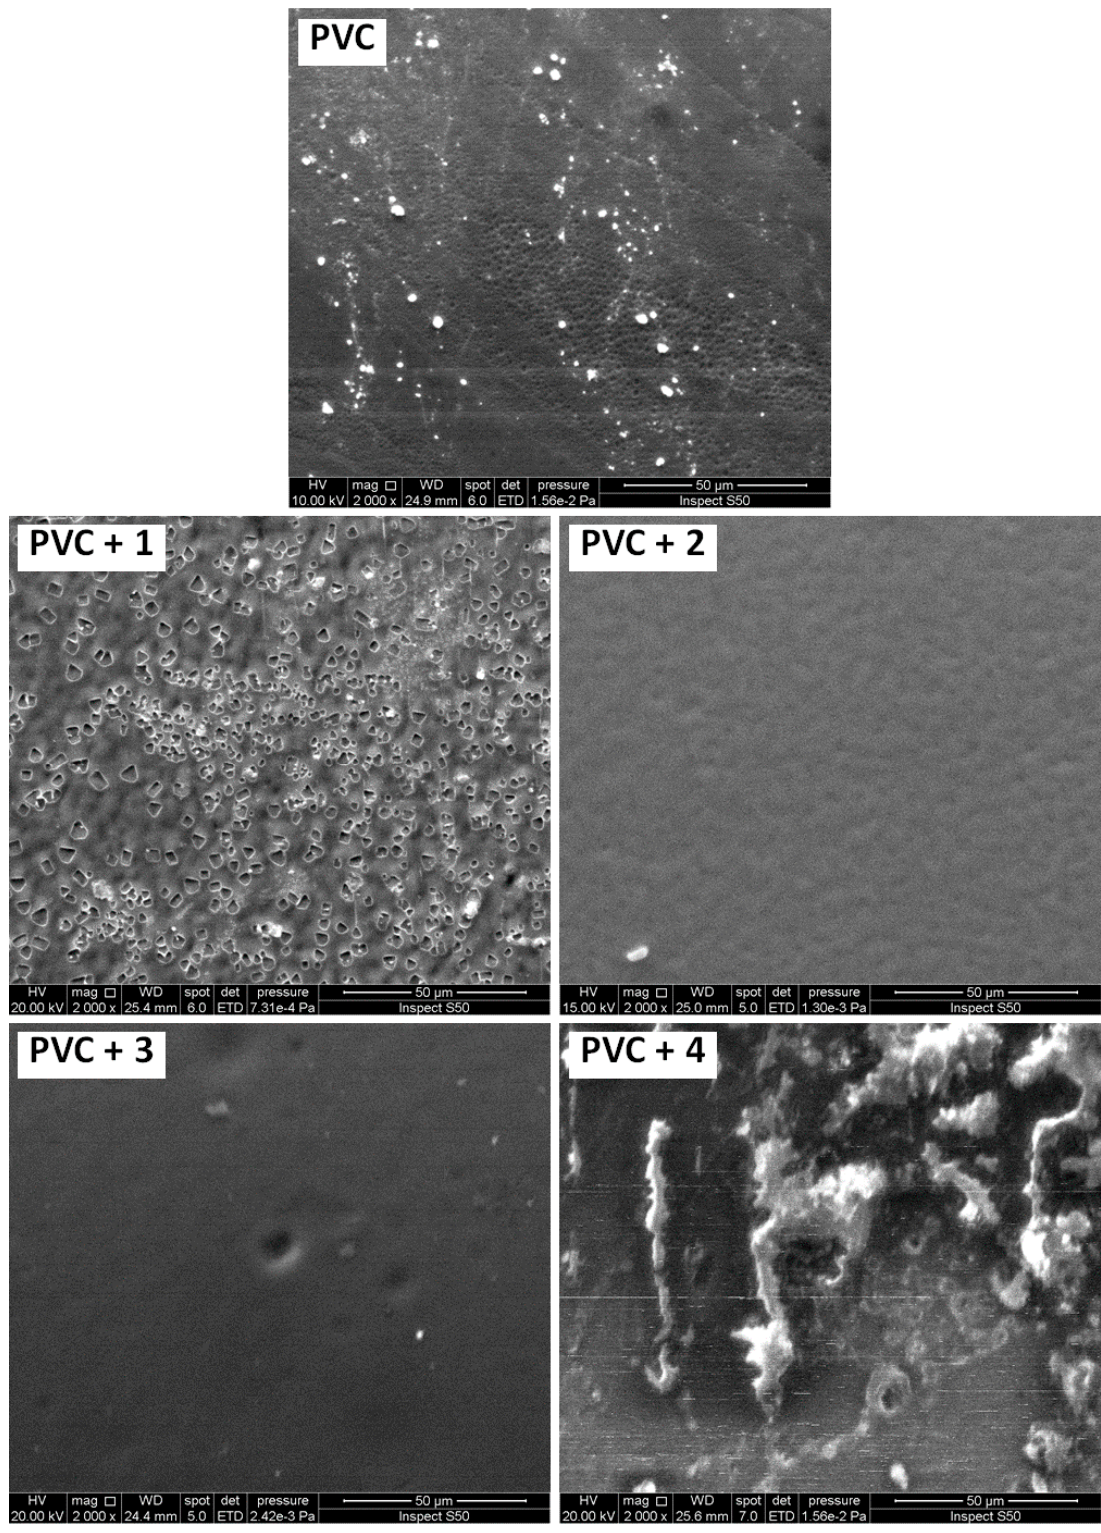
Figure 7. SEM images of the PVC films.